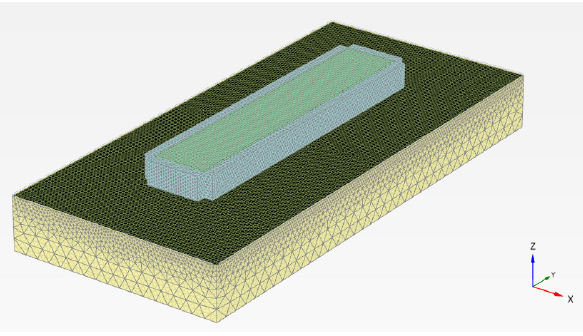
Figure 2: Three-dimensional view of the generated